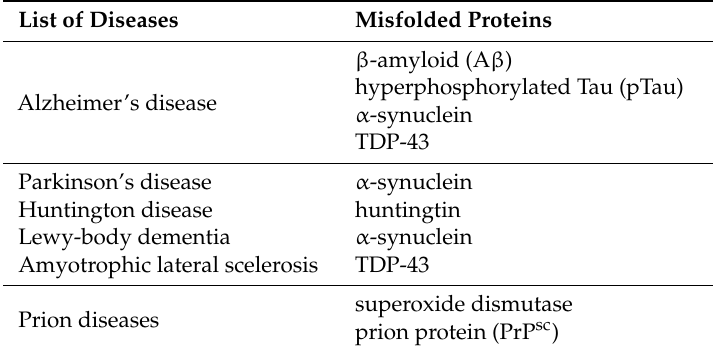
Table 1. Examples for protein conformational, neurodegenerative diseases as well as their corresponding misfolded